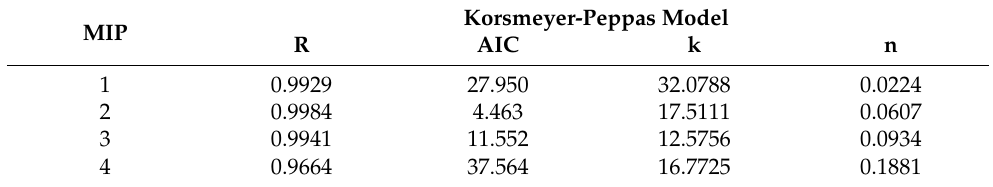
Table 5. Drug release kinetics at pH =